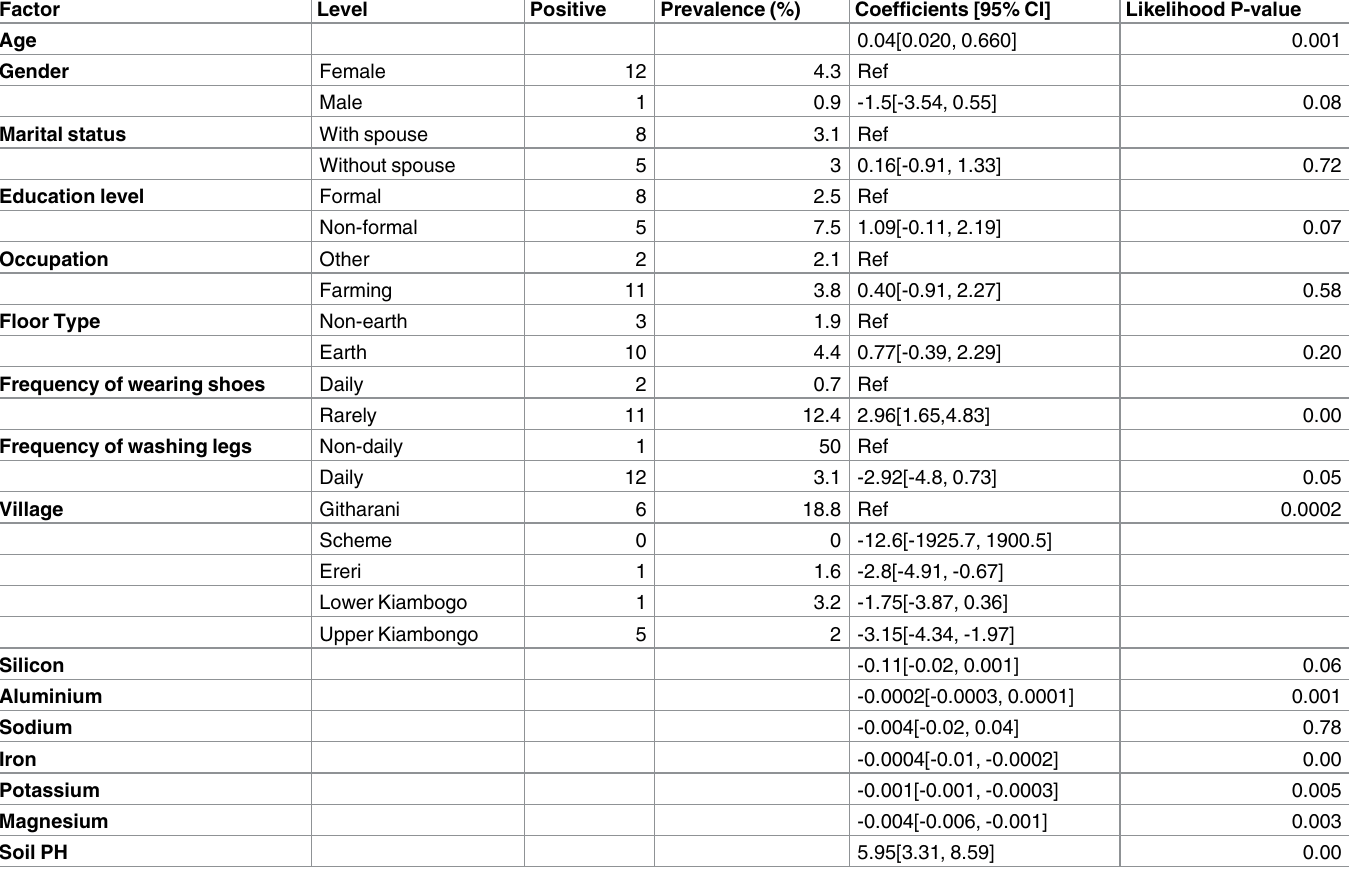
Table 6. Counts and prevalenceof Podoconiosis and univariable analysesrelating the counts of Podoconiosis and risk factors collected in Mt Longonot area, Kenya. Factor